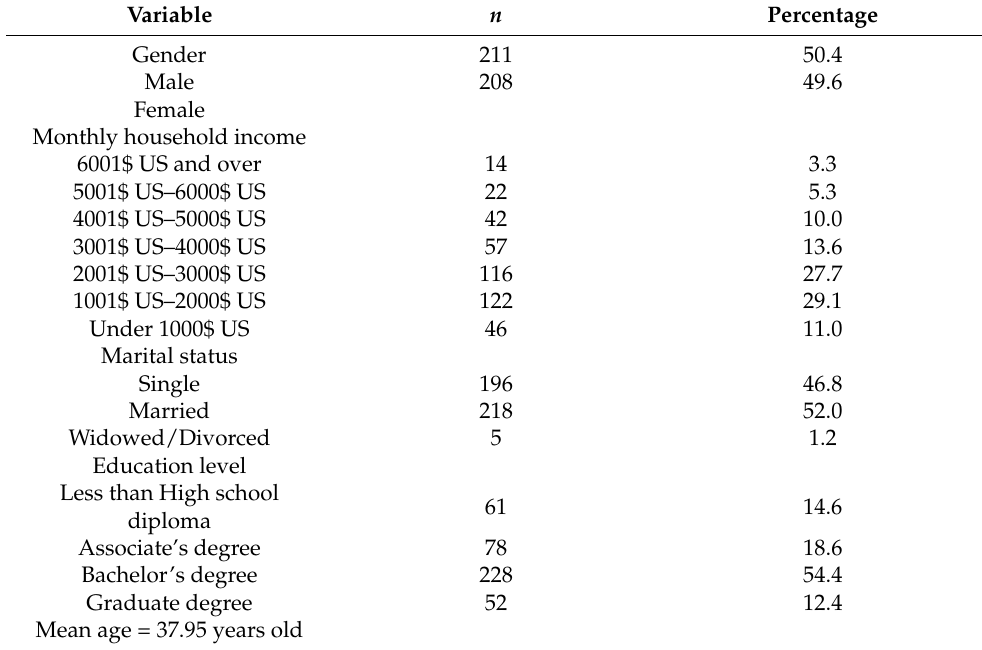
Table 1. Profile of survey respondents ( n =